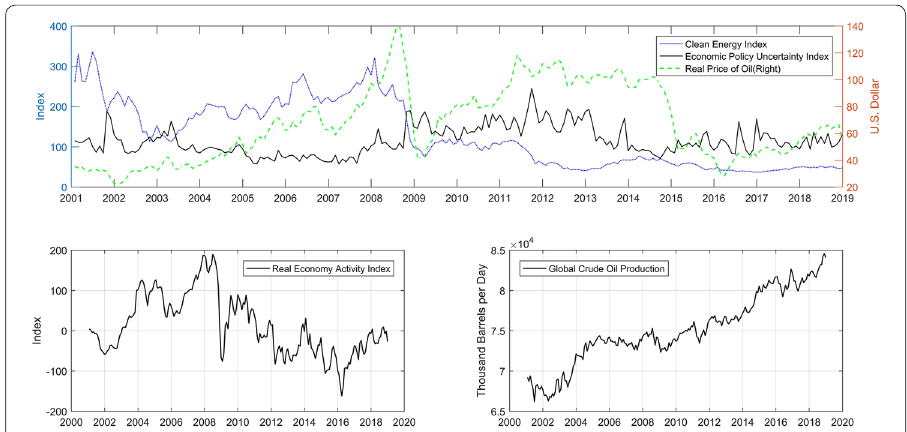
Fig. 1 Time trends of main variables, 2001:01–2018:12. Notes: Subplot A shows monthly data of real oil prices, economic policy uncertainty index and the real stock return of oil and gas industry. Subplot B